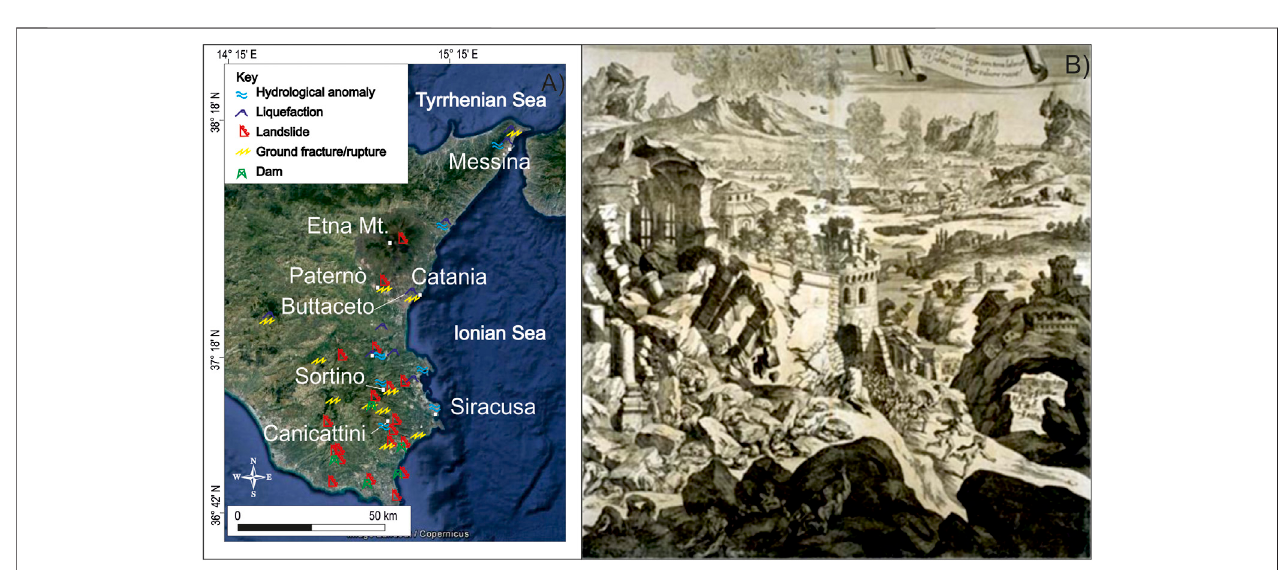
FIGURE 5 | (A) Detailed relocation of the 1693 environmental effects. (B) A German copper incision showing the 1693 earthquake. In the foreground, we can see the damaged Hyblean cities, behind the plain of Catania and environmental phenomena and, at the bottom, the Etna Volcano.